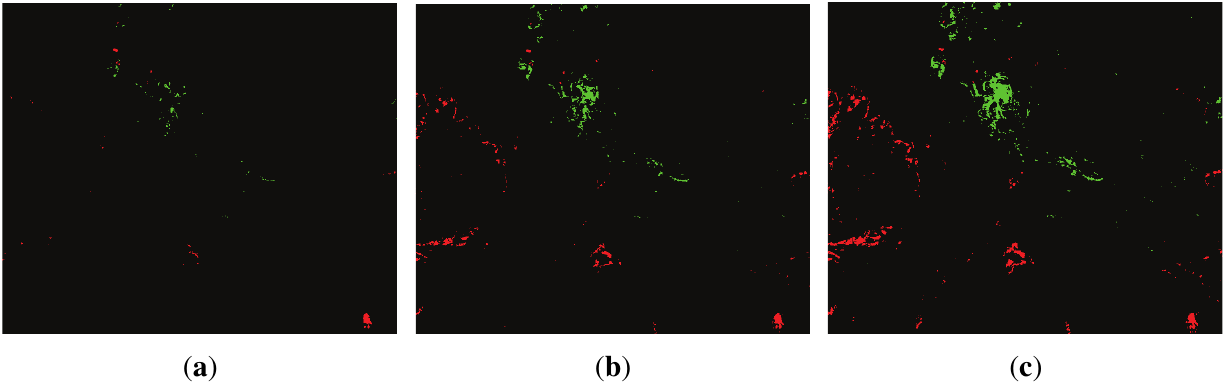
Figure 4. The distribution maps of outliers in Cuprite in Section 3.3. ξ % of the pixels at the top (red points) of each component and ξ % of pixels at the bottom (green points) of each component are considered as the outliers (from left to right are shown with ξ = 0 . 1 , 0 . 5 , 1 ,